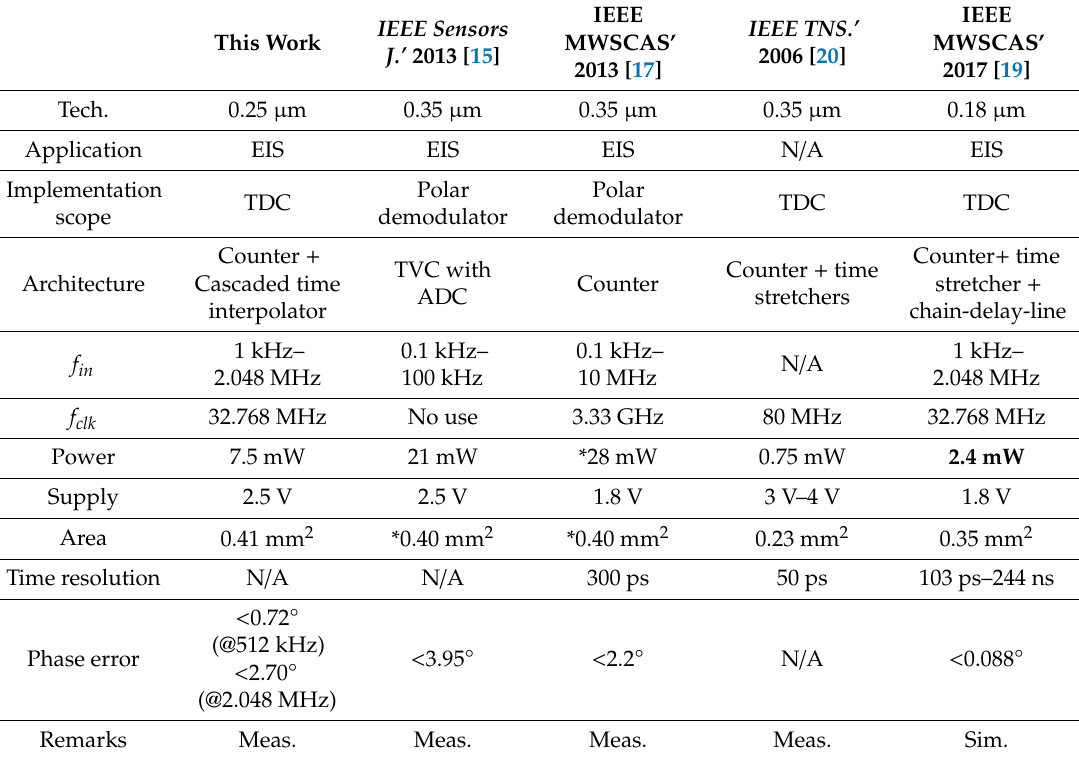
Table 5. Performance summary and